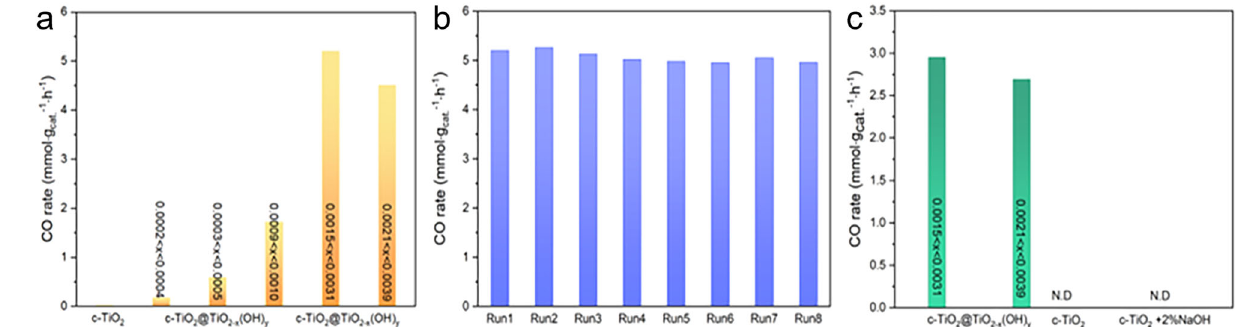
Fig. 6 | Photocatalytic performance of oxides in the batch reactor without external heating. Initial reactants were 15psi of CO 2 and 15psi of H 2 (total pressureof ca .2bar).a Non-stoichiometrydependentCOproductionratesofthe c-TiO 2 @a-TiO 2-x (OH) y under full-spectrum Xe light, 4.0Wcm − 2 . b Stability